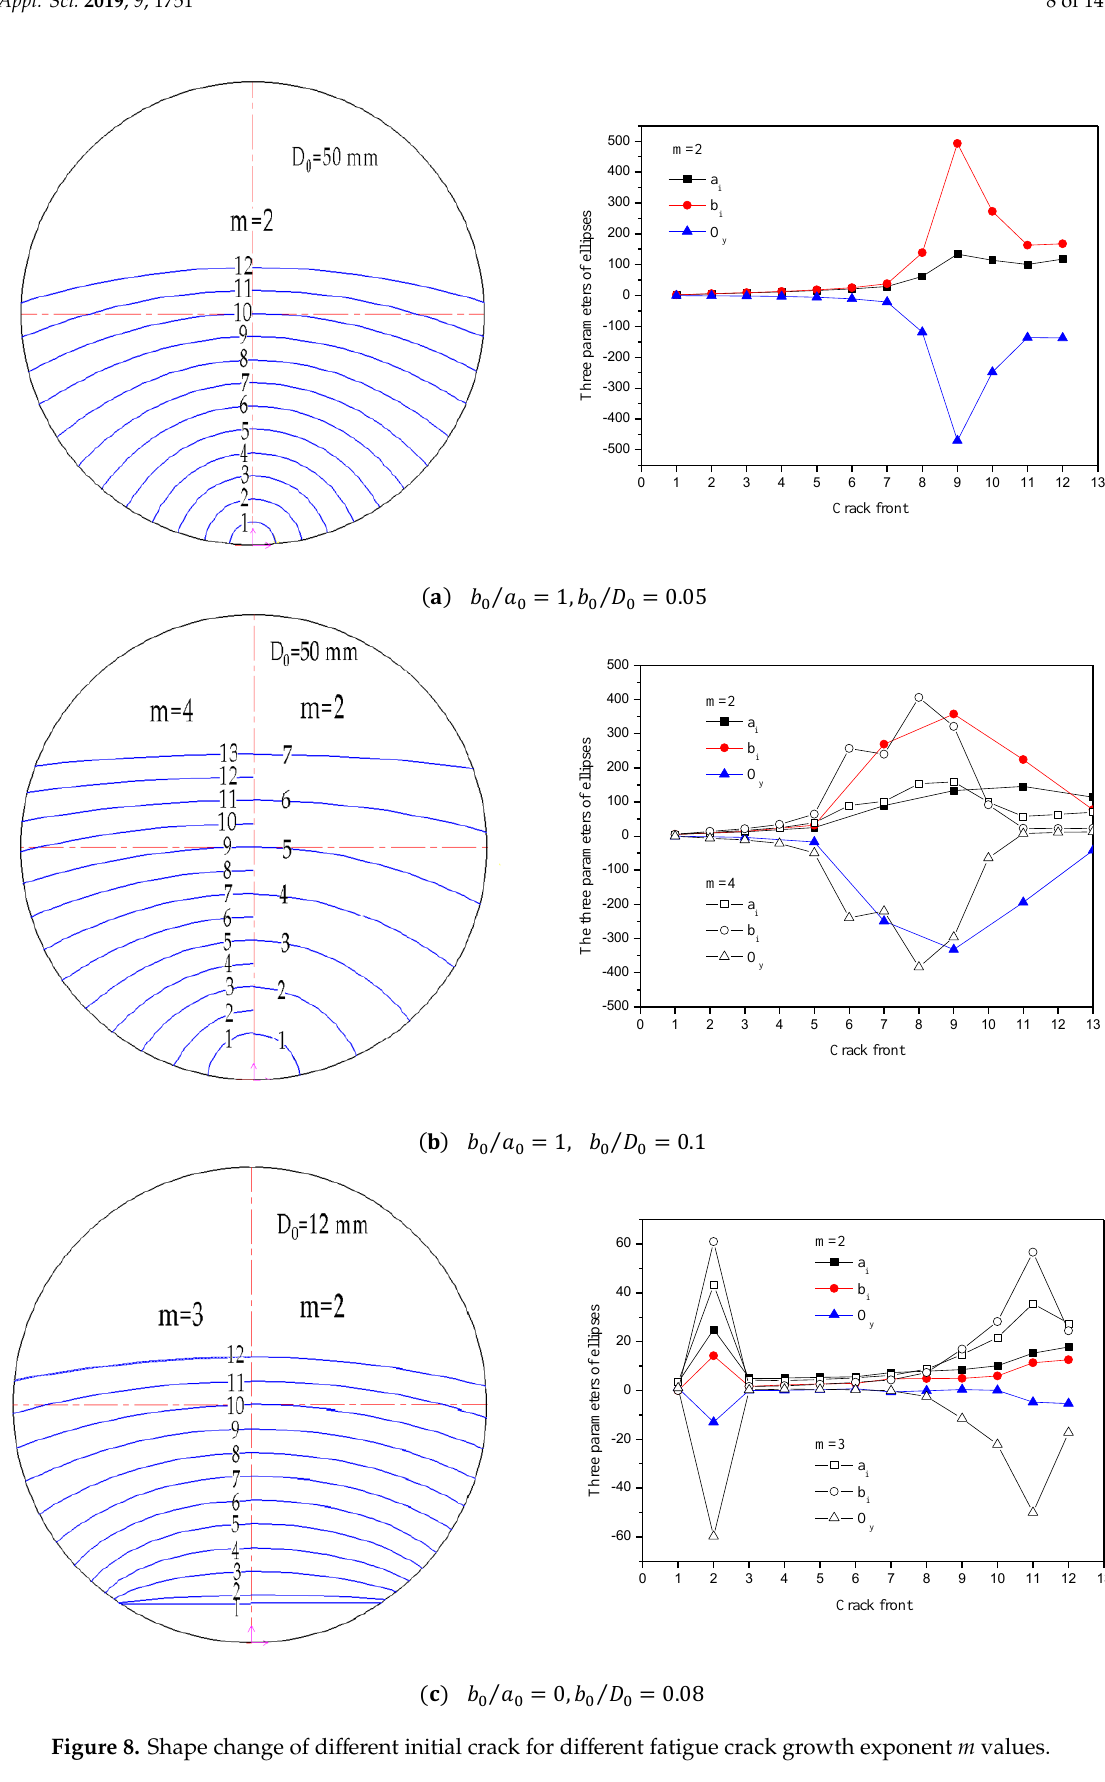
Figure 8. Shape change of different initial crack for different fatigue crack growth exponent 𝑚 values.